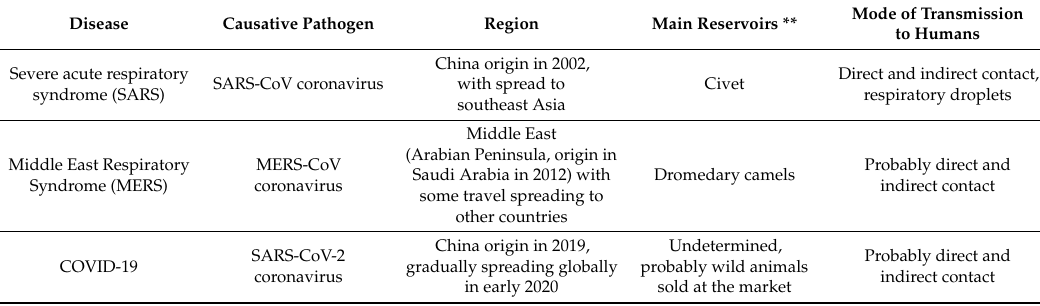
Table 2. Coronavirus zoonoses